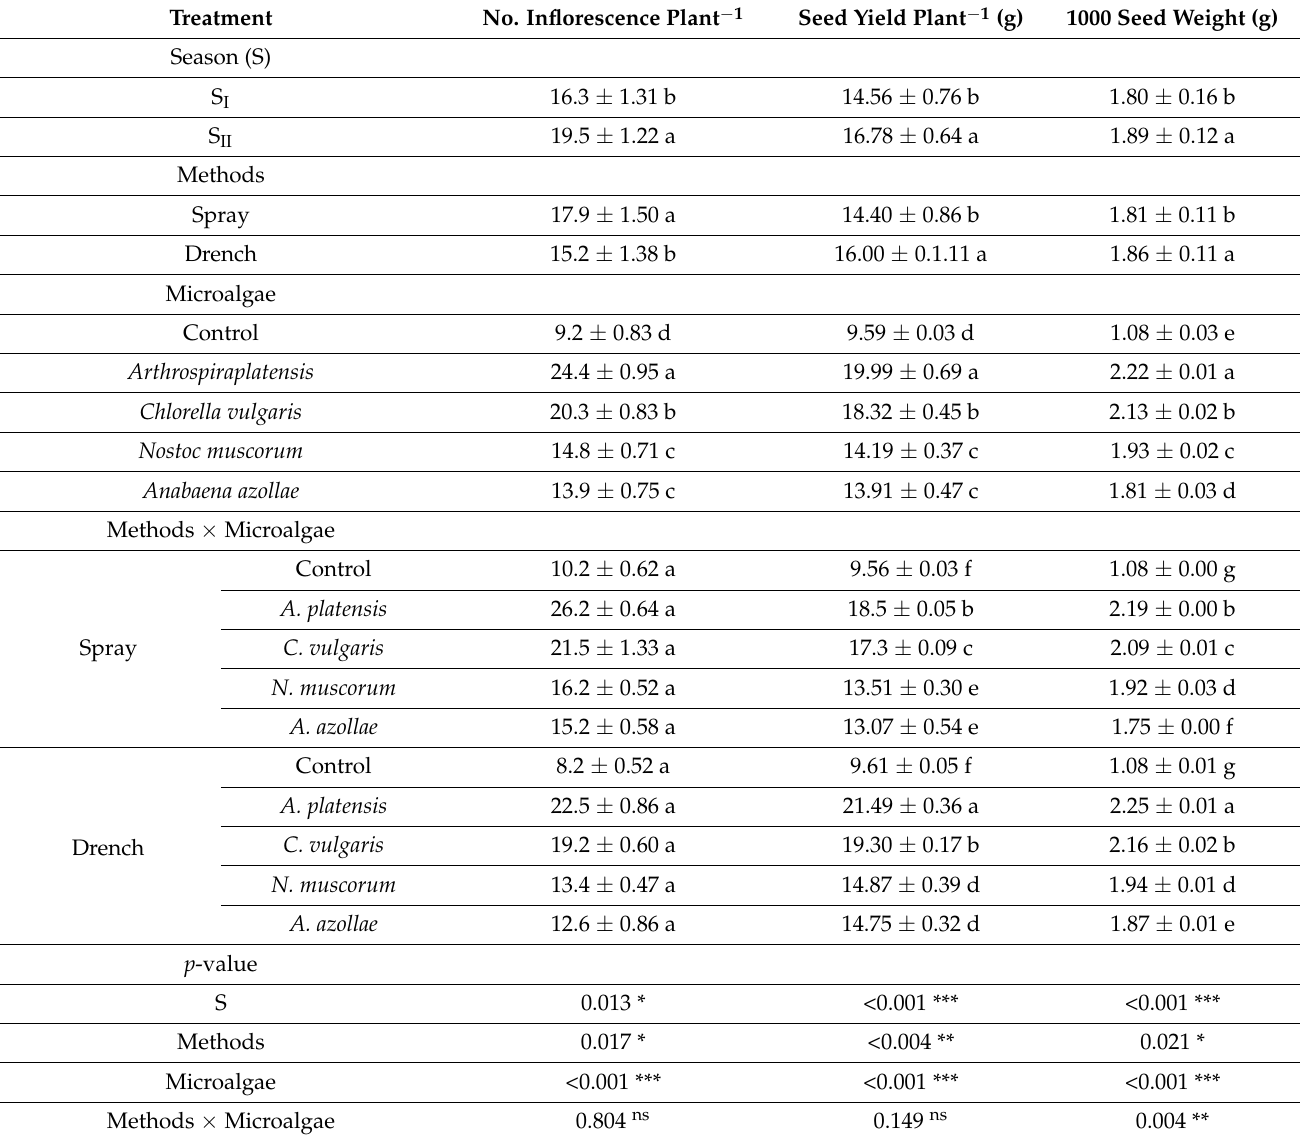
Table 3. Number of inflorescence plant − 1 , seed yield plant − 1 , and 1000 seed weight of chia plants cultivated under alkaline stress conditions in response to different application methods, microalgae strains, and their